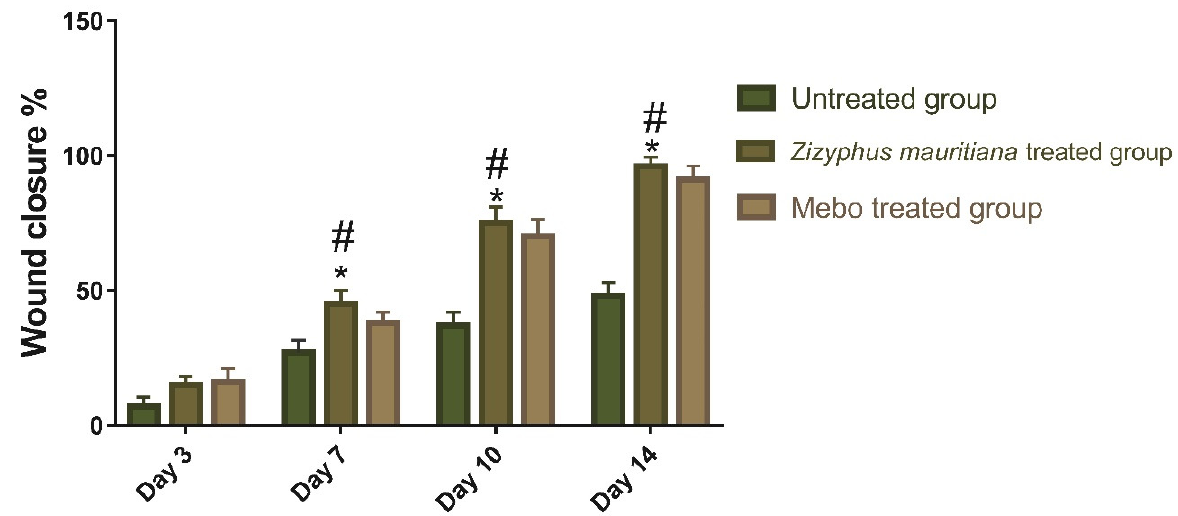
Figure 4. Wound closure rates: Group 1: untreated group (negative control), Group 2: ZFE extract-treated group, Group 3: MEBO ® -treated group (positive control) over time post-injury (0, 3, 7, 10, and 14 days). The significant difference between groups analyzed by a Two-way ANOVA test after normalization of variables by the Shapiro Wilk test. Data were expressed as mean ± SD. * p < 0.001 compared with those of the untreated group on the respective day and # p < 0.001 compared with those of the MEBO ® group on the respective day.